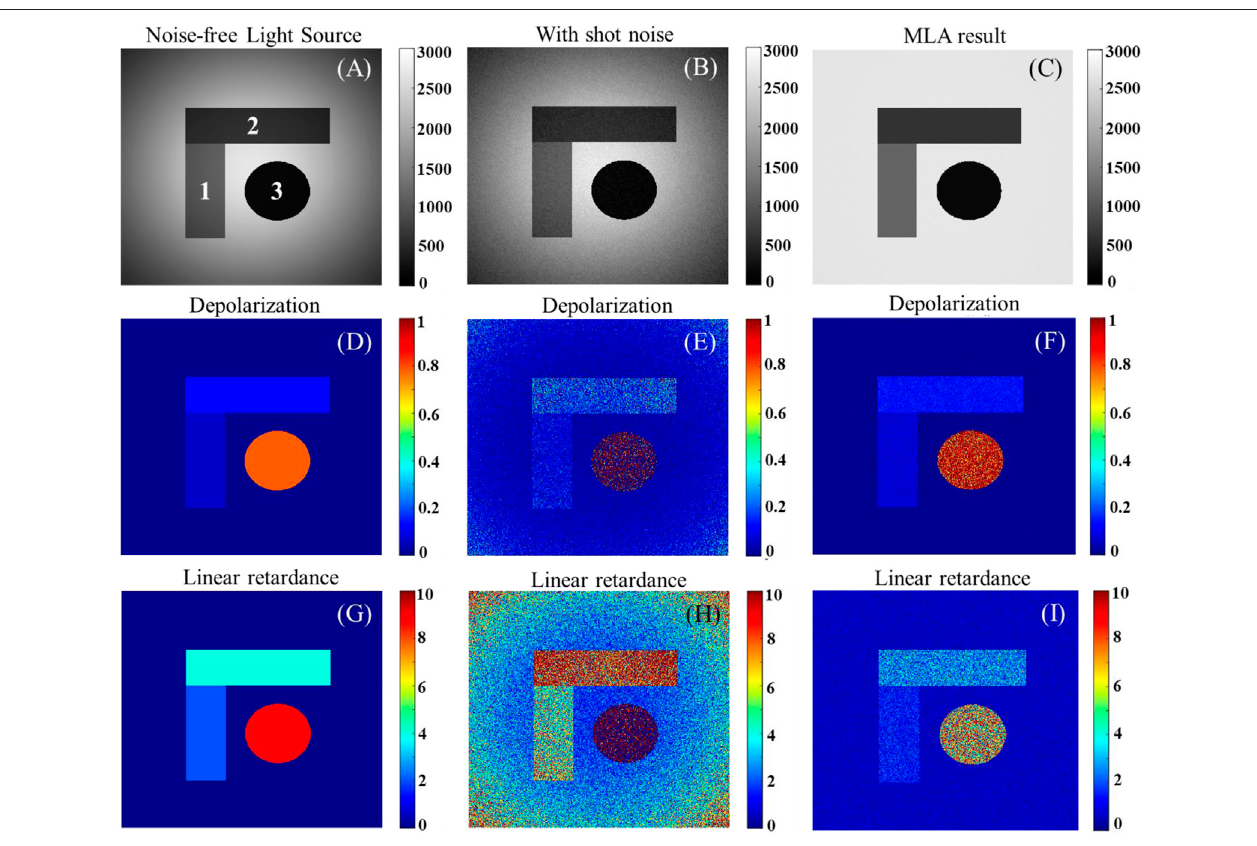
FIGURE 5 | (A) , (B) , and (C) : three typical cases for the fi rst light intensity image for three domains; (D) -(F) and (G) -(I) are the corresponding calculated depolarization and linear retardance for three domains under three typical cases, respectively.